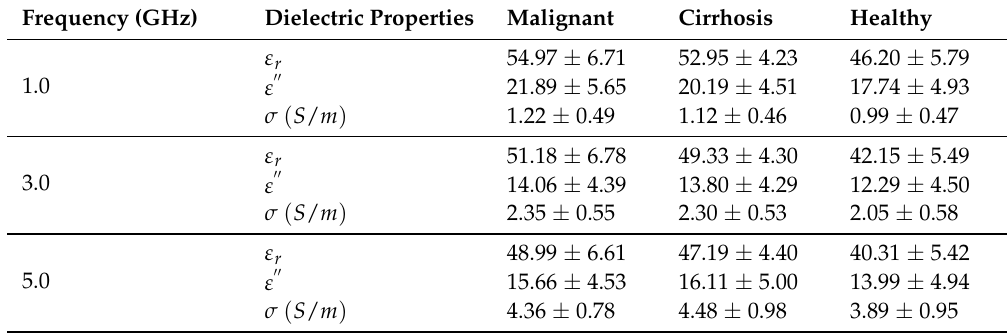
Table 2. Comparison of mean measured in vivo dielectric properties of rat hepatic tissues along with combined uncertainty values.